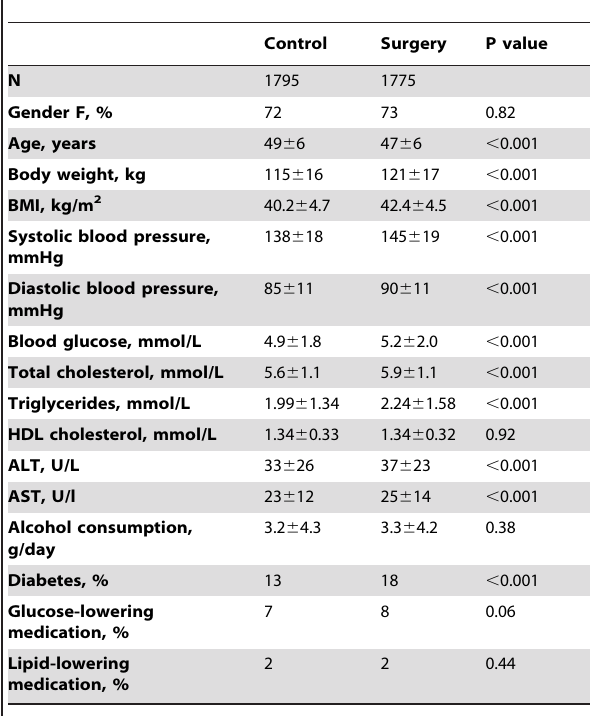
Table 1. Baseline characteristics of the individuals from the SOS study included in this